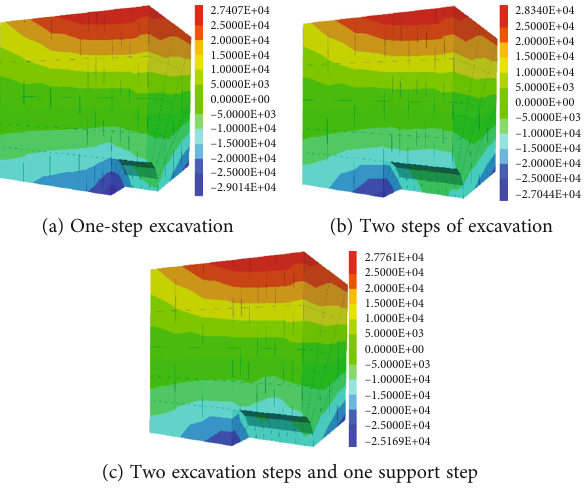
Figure 5: Horizontal stress nephogram.